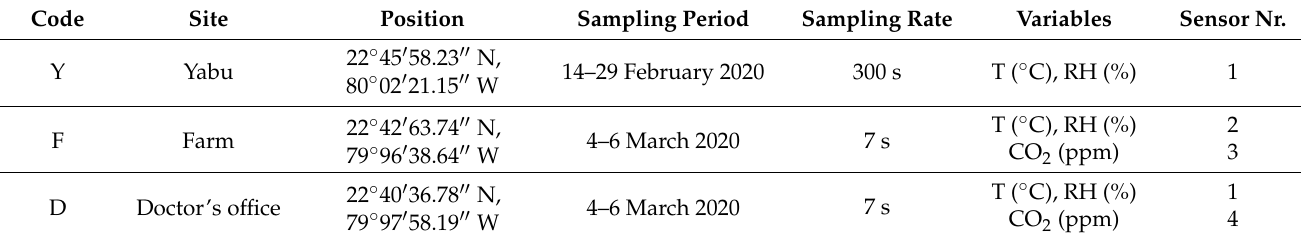
Table 3. Sampling sites and an organizational overview of the field test.